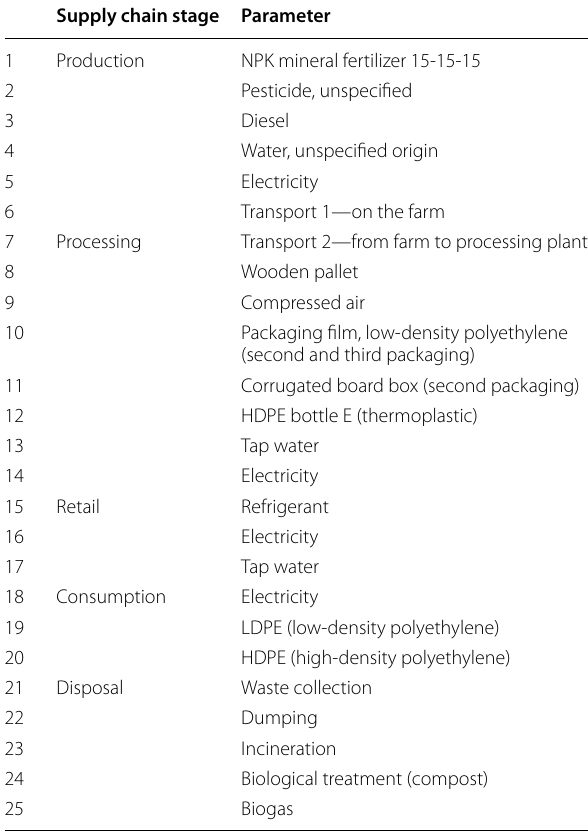
the quantification of the three scenarios Supply chain stage